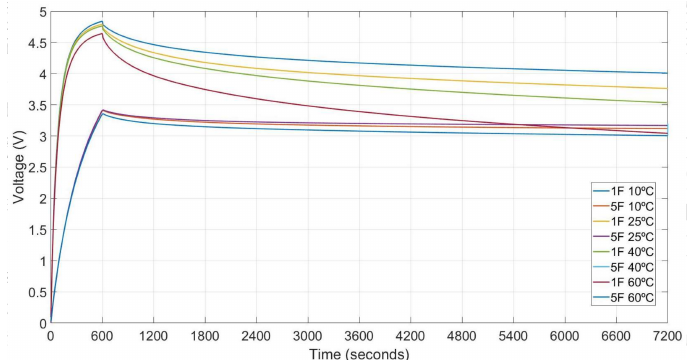
Figure 4. Charge and discharge profiles at 10, 25, 40 and 60 ◦ C for supercapacitors of 1 and 5 F.